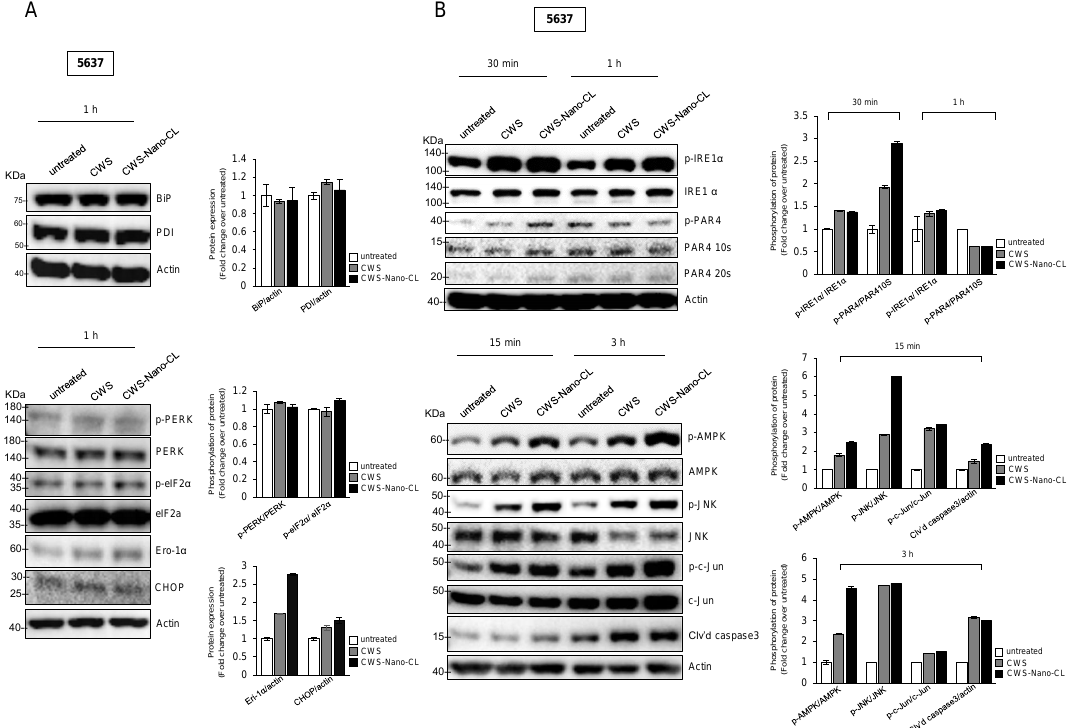
Figure 5. E ff ect of CWS-loaded formulations on ER stress-induced apoptosis via AMPK activation in bladder cancer cells. ( A ) Cells were treated with 1 µ g / mL of CWS or CWS-Nano-CL for 1 h, and then, ER stress-adaptive proteins (Bip and PDI) were detected by Western blotting (left panel). ER stress-induced mediating proteins were determined by the expression of phosphorylated PERK / PERK, phosphorylated elf2 α / elf2 α , Ero-1 α , and CHOP (right panel). ( B ) Cells were treated with 1 µ g / mL of CWS or CWS-Nano-CL for 30 min and 1 h, and then, phosphorylated IRE1 α / IRE1 α and phosphorylated PAR4 / PAR4, ER stress-inducing apoptotic proteins, were detected by Western blotting (leftpanel). After15minand3hoftreatment, thelysateswereanalyzedbyWesternblottingusingspecific antibodies for the indicated proteins (right panel). CWS- and CWS-Nano-CL-induced AMPK activation mediated JNK–c-Jun-caspase 3 signaling downstream of IRE1 α . The blots are representative of three independent experiments. The quantification graphs represent BIP / Actin, PDI / Actin, p-PERK / PERK, p-eIF2 α / eIF2 α , Ero-1 α / Actin, CHOP / Actin, p-IRE1 α / IRE1 α , p-PAR4 / PAR410S, p-AMPK / AMPK, p-JNK / JNK, p-c-Jun / c-Jun, and Cl’vd PARP / Actin ratios determined by densitometric analyses. All expression ratios were normalized to the untreated